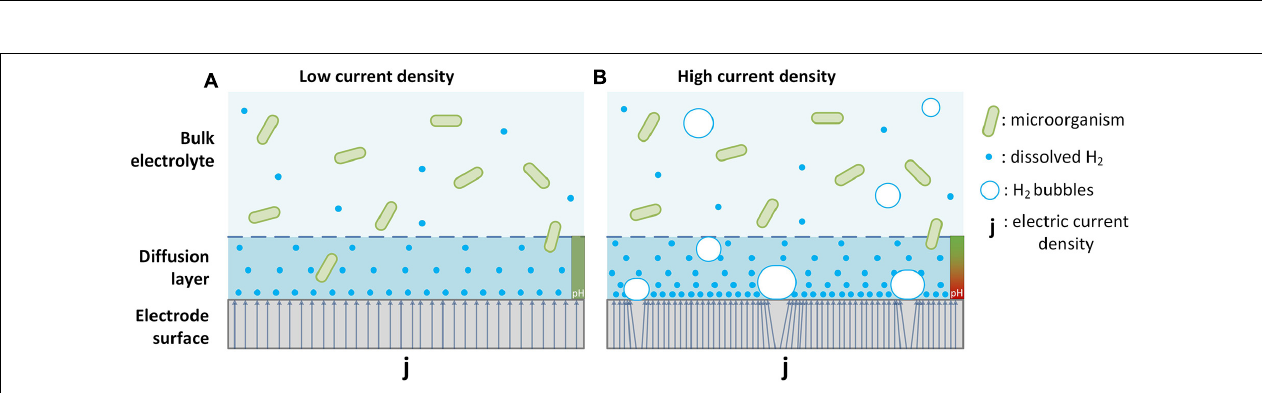
FIGURE 5 | Summary of process parameters during electromethanogenesis in dependency of the applied cathodic current density: (A) The rates of methane (diamonds, left axis) and H 2 (squares, right axis) produced per cathode area, (B) coulombic efficiencies for methane (circles) and (C) steady state biomass concentrations (triangles). Eight individual electrodes of four different surface areas 39, 55, 86, and 111 cm 2 were tested under constant current conditions of 50, 60, 70, and 80 mA. The given values are averages of 4–12 individual measurements under steady state conditions with error bars displaying the standard deviation between individual measurements.